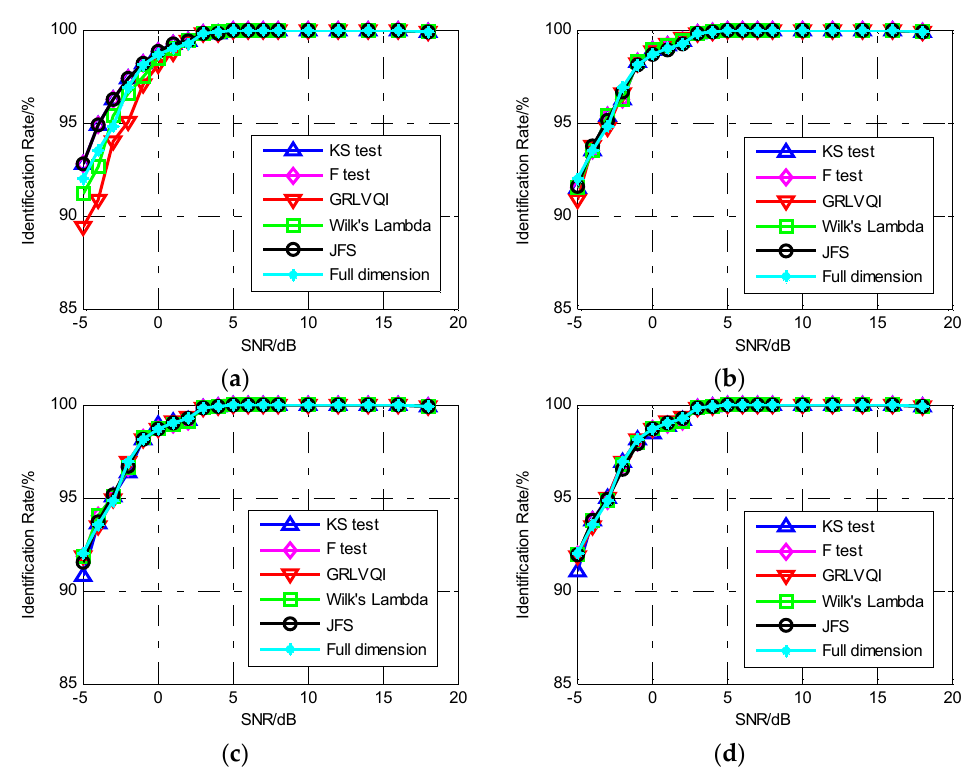
Figure 7. The performance of the SVM classification for linear frequency modulations (LFMs) with di ff erent envelopes being classified into two classes using IMF-DNA. ( a ) N d = 10. ( b ) N d = 30. ( c ) N d =